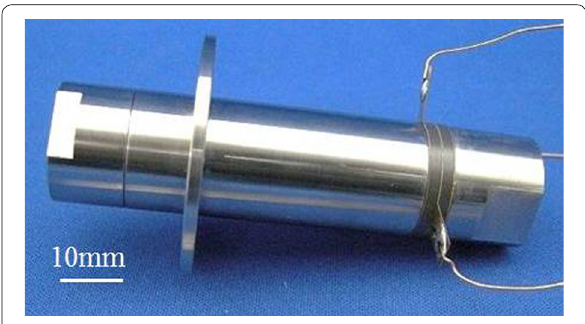
Fig. 6 Assembled